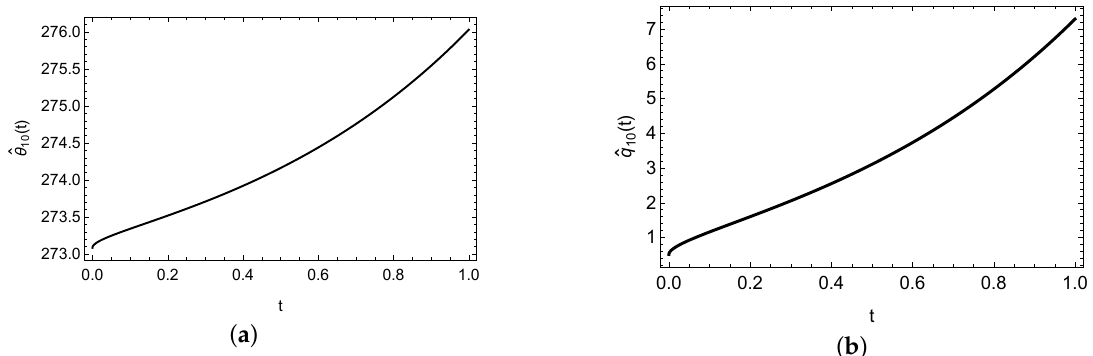
Figure 3. The reconstructed boundary conditions: ( a ) temperature distribution (cid:98) θ 10 , ( b ) heat flux (cid:98) q 10 .